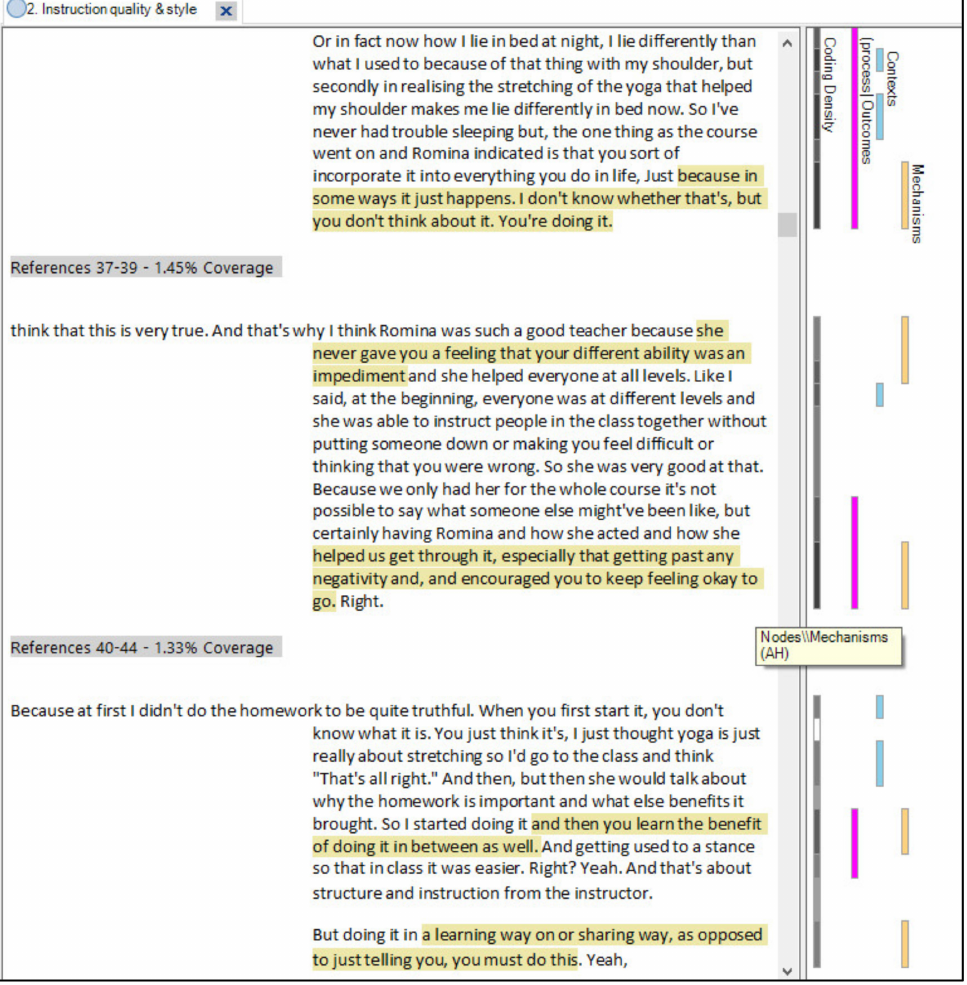
Figure 4. An example of how the natural connections between context, mechanism and outcomes can be preserved within the narrative text in a theory node. Here, the mechanism code is